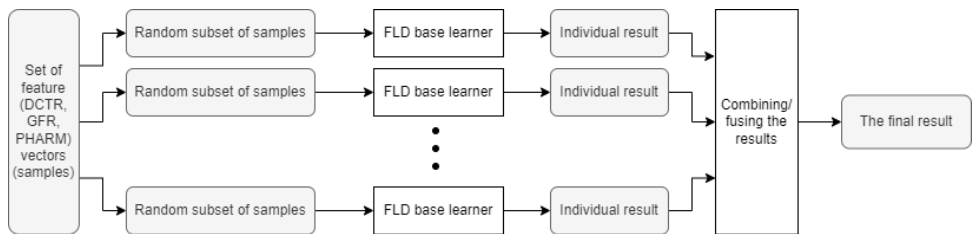
Figure 2. A diagram showing the structure of the ensemble